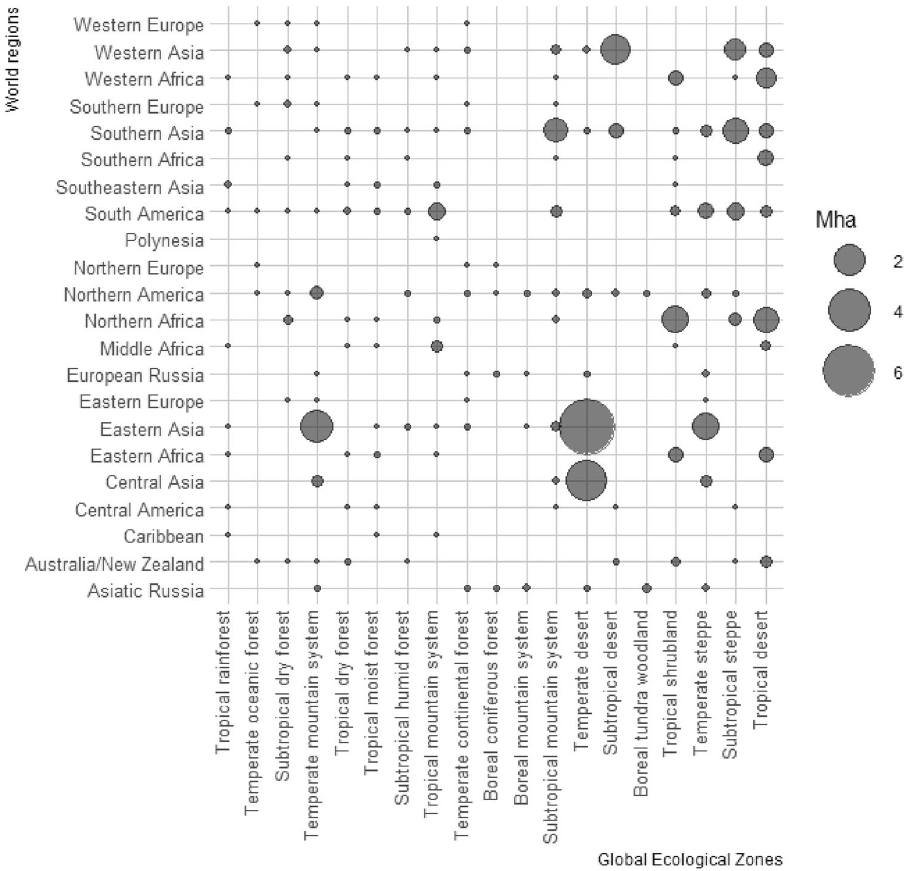
Figure 2. Relative geographical concentration of identified target